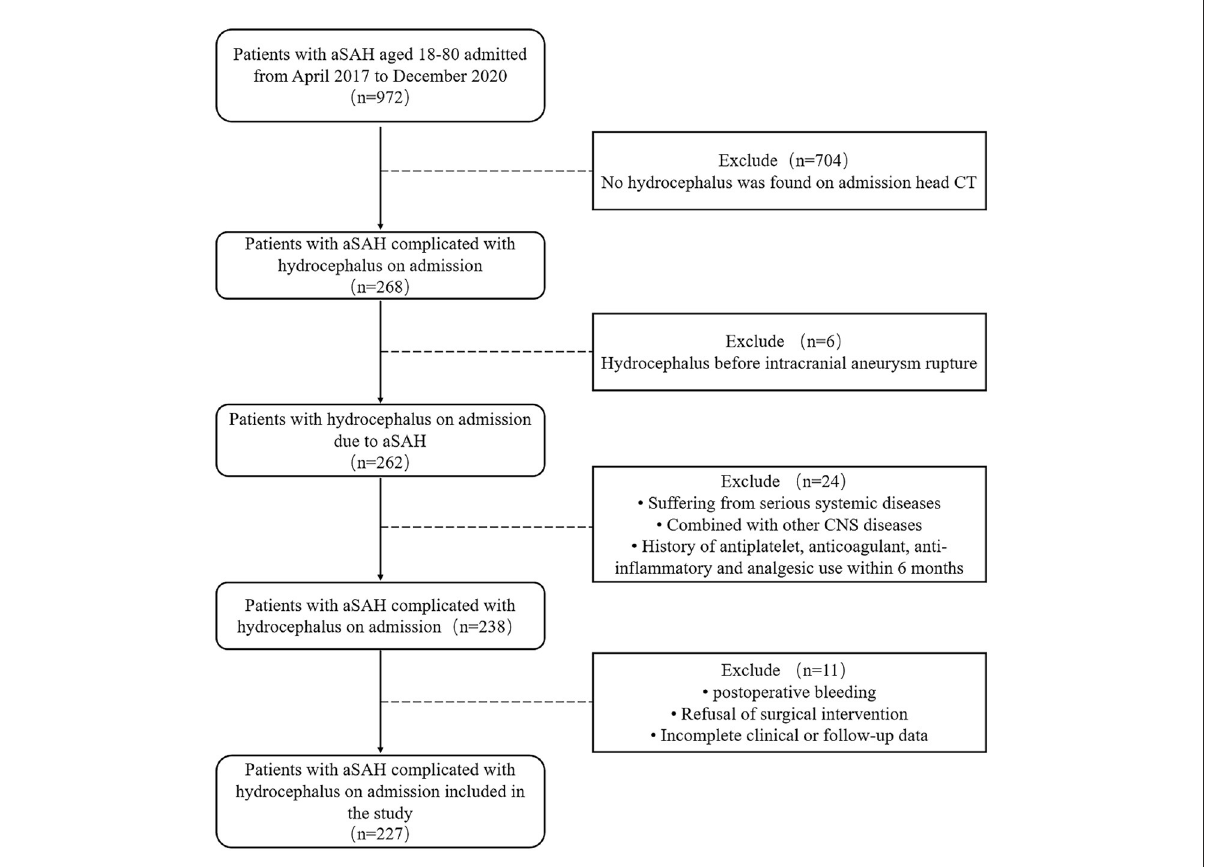
FIGURE1 Flow chart of patient